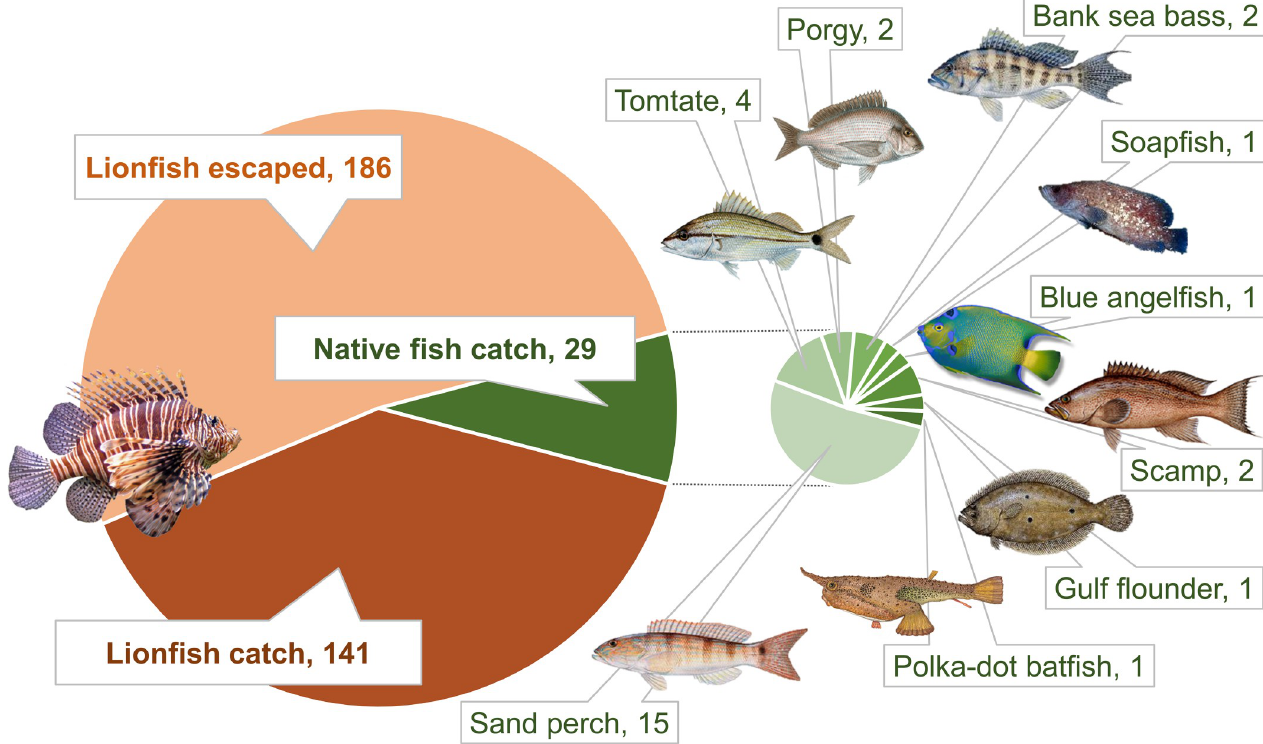
Fig 4. Number and species of fishes in the Gittings traps. Total counts of lionfish caught, lionfish escaped, and native fish caught in traps deployed near northern Gulf of Mexico artificial reefs during 82 trap deployments. Sizes of pie slices correspond to the proportion of total fish caught. Fish images are not drawn to